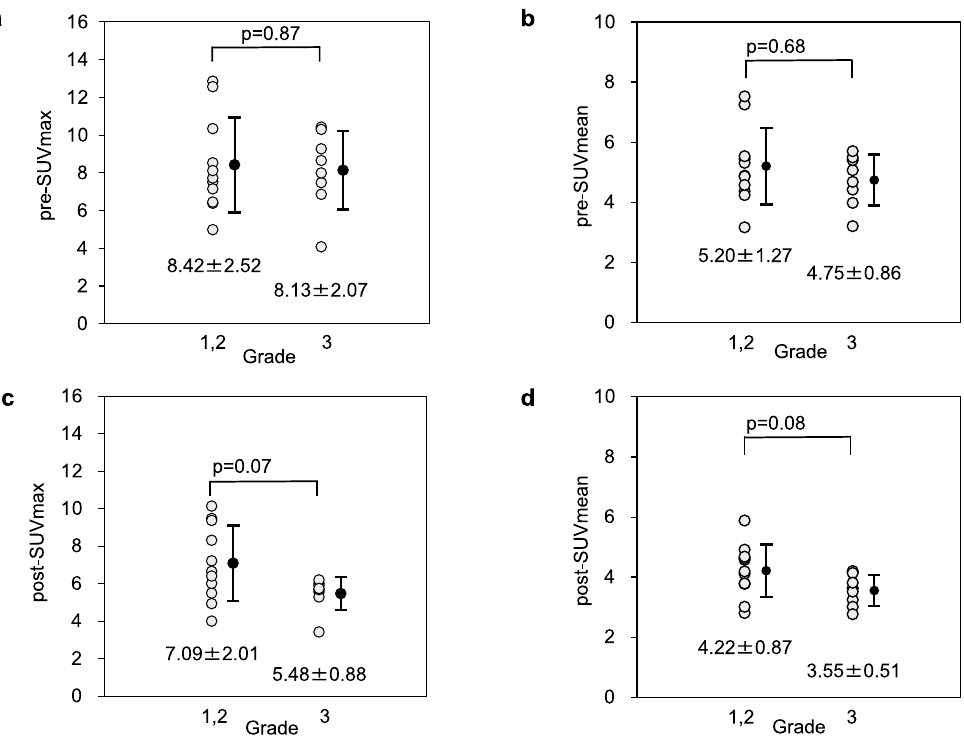
Figure 2. Relationship between MET and Grades 1, 2, and 3. There was no significant difference in PET imaging parameters among Grades 1, 2, and 3. ( a ) pre-SUVmax. ( b ) pre-SUVmean. ( c ) post-SUVmax. ( d ) post- SUVmean. The Mann–Whitney U test was used for statistical analysis.